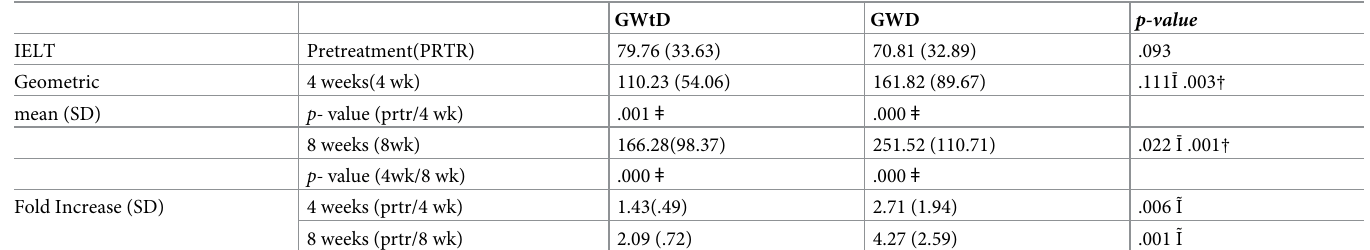
Table 3. Intravaginal Ejaculatory Latency Times (IELT) and Fold Increase (FI) during the study.